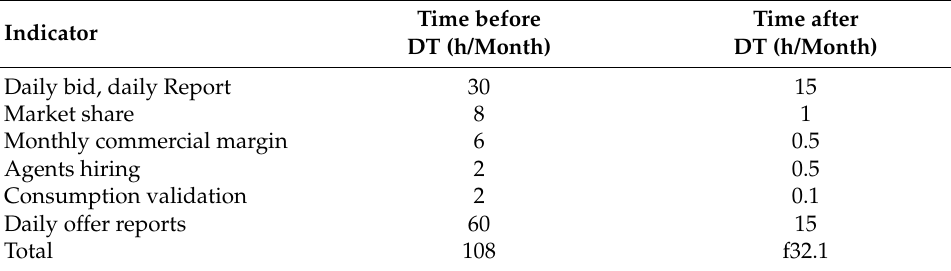
Table 2. Time comparison for reports generation.